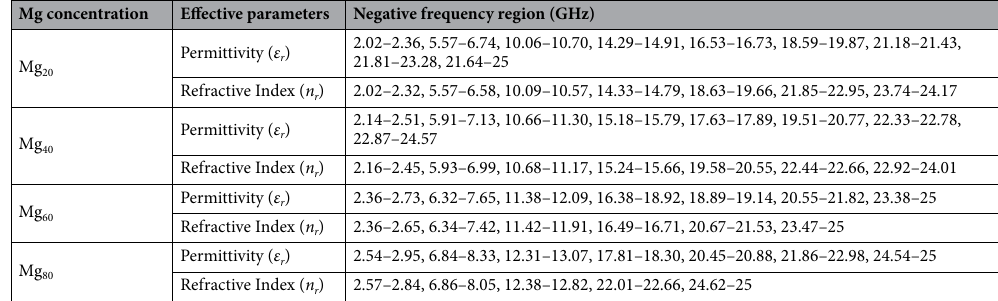
Table 3. Negative values of effective parameters among Mg 20 , Mg 40 , Mg 60 , and Mg 80 .